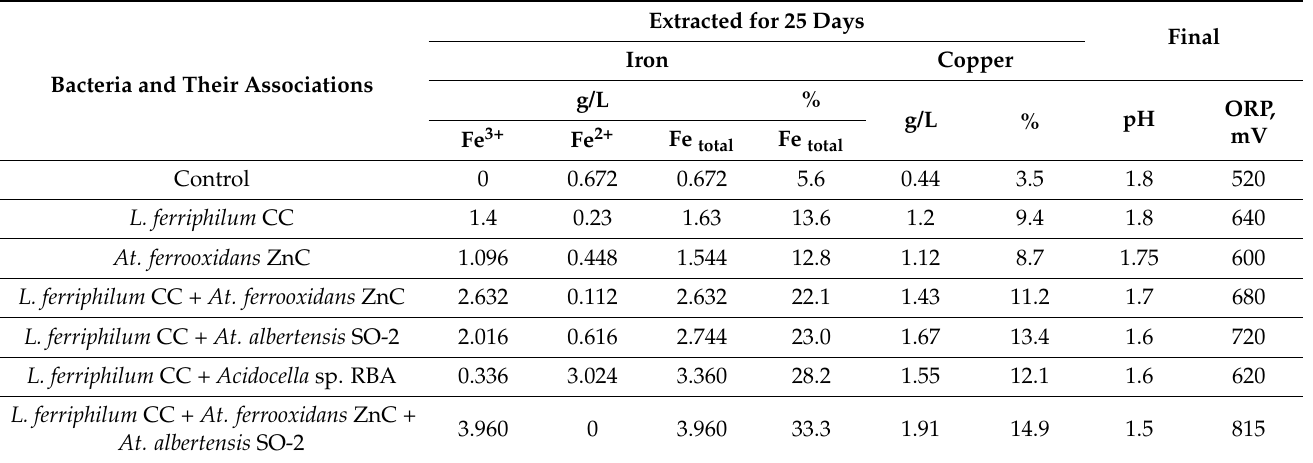
Table 3. Leaching of iron and copper from chalcopyrite by L. ferriphilum CC and association with iron- and sulfur-oxidizing and heterotrophic